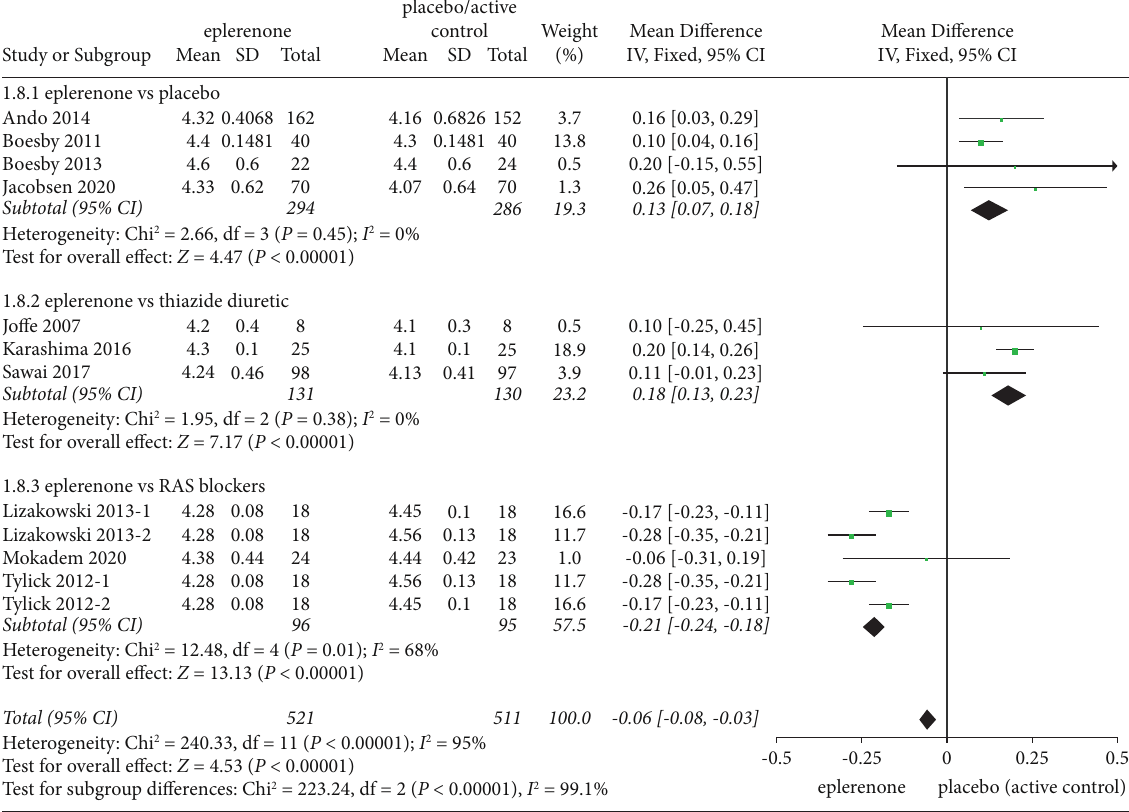
Figure 6: Forest plots of the efect on serum potassium levels in articles between the eplerenone treatment groups and the control group. Te black diamond indicates summary information with the center of the estimate pooled with the median diference, and the width covers the relevant 95%